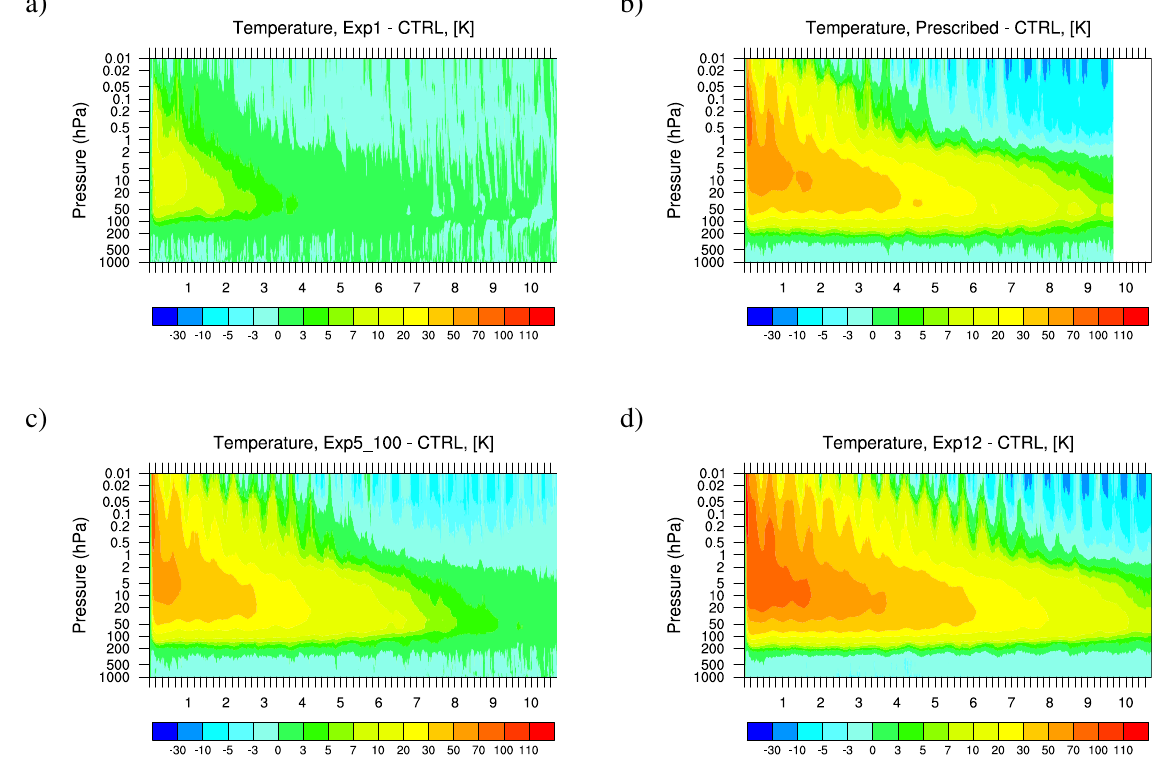
Fig. 4. Change in global mean temperature [K] as a function of altitude and time. (a) Exp1, (b) Prescribed run, (c) Exp5_100, (d) Exp12. Table 3. Comparison of winter (DJF, first year) temperature changes for specific